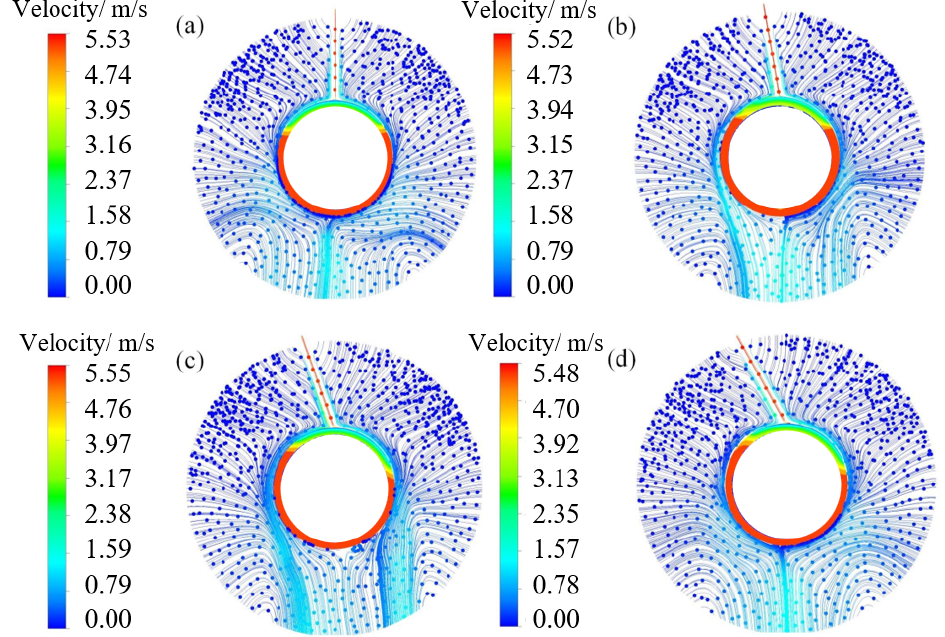
Figure 5. Flow field distribution velocity contour of top jet impacting cooling steel tube. ( a ) θ = 0°; ( b ) θ = 10°; ( c ) θ = 20°; ( d ) θ = 30°.